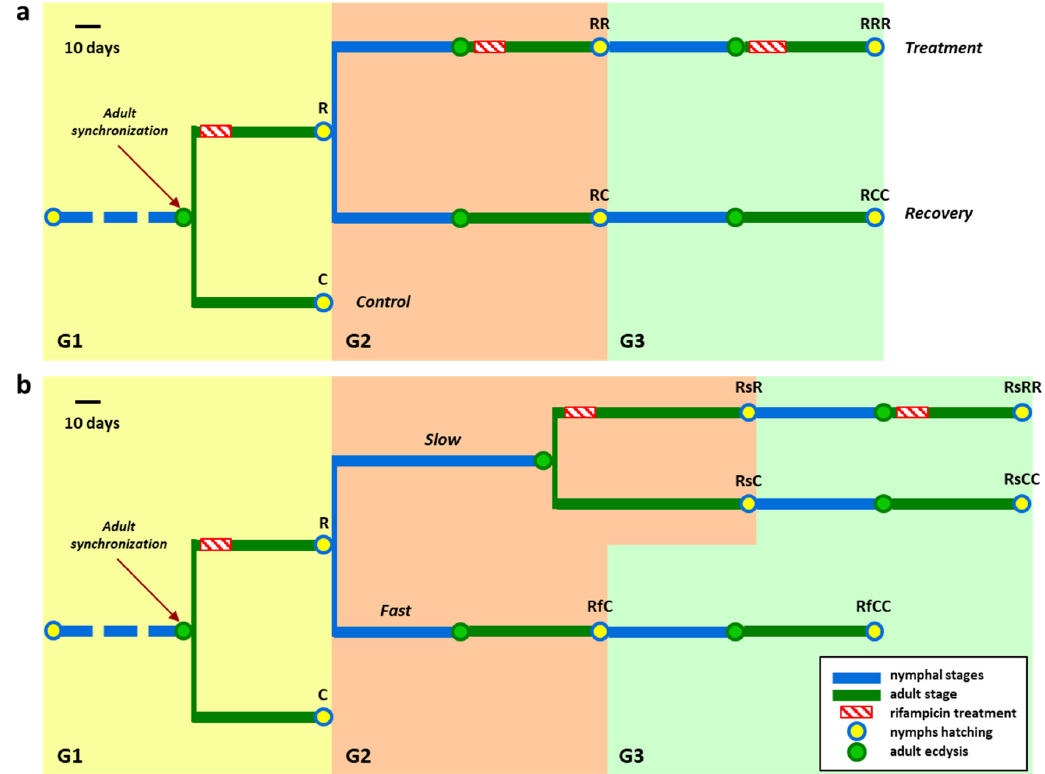
Figure 1. Experimental design to obtain B. germanica quasi-aposymbionts without affecting the gut microbiota. ( a ) Original design. The antibiotic rifampicin is supplied to a synchronized adult population of B. germanica in three successive generations. At G1, the following two populations are established: a control one without antibiotic (C) and another one treated with rifampicin for the first 12 days of the adult stage (R). At G2, within 48 h of hatching, nymphs of the antibiotic-treated population are used to start two new populations, with and without antibiotic treatment in the adult stage (RR and RC, respectively). At G3, the antibiotic is supplied again to the treated population only (RRR) in the adult stage, while the sister population remains untreated (RCC) to allow a complete recovery. ( b ) Modified design. Because the nymphs that hatched after the first rifampicin treatment present two developmental phenotypes (slow and fast), only those with a delay in their developmental time were used for the rifampicin treatment over three generations, and to analyse their recovery after ceasing the antibiotic treatment for two generations. Adult females were taken for dissection after the hatching of nymphs in G2 and G3.